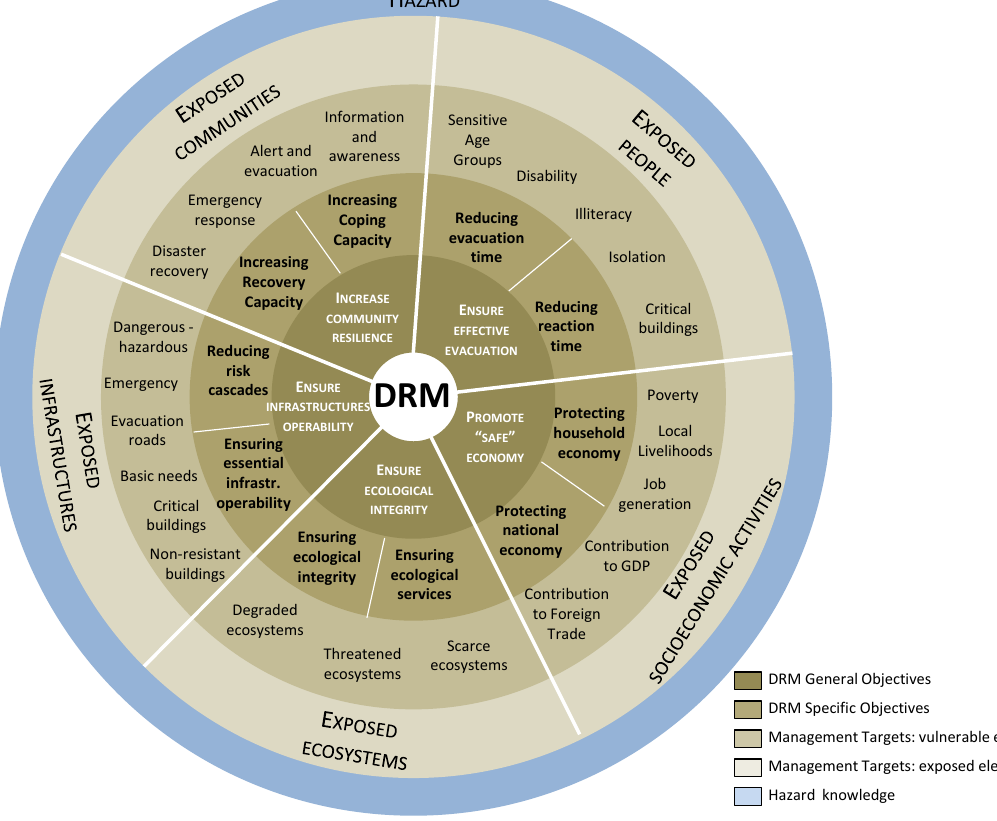
Figure 9. Example of risk management framework for tsunami hazard in El